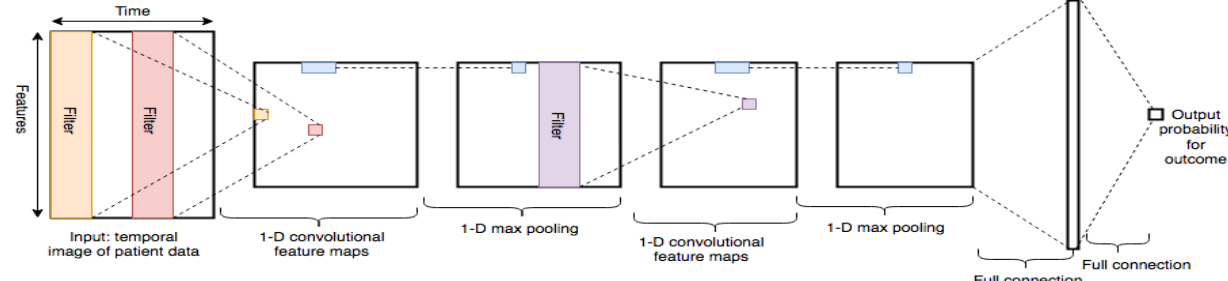
Figure 2. Illustration of the deep neural network.